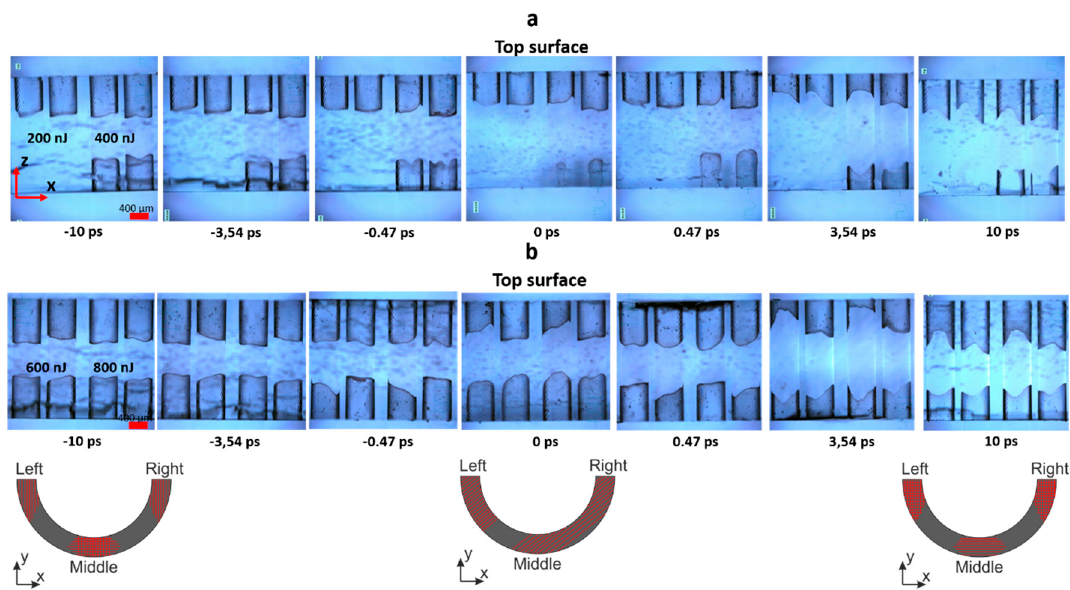
Figure 7. The microscope measurement of the etching dependence on the double-pulse delay for the bow-like vertical structures from the sample side (ZX plane): ( a ) the structures recorded with 200 nJ and 400 nJ pulse energy and ( b ) the structures inscribed with 600 nJ and 800 nJ pulse energy. Two channels with 500 and 1000 ppµ density were recorded at the constant pulse energy. Etching performed for 30 min. in 10% HF. The inset shows the bow-like trajectory view on the XY plane with a predicted nanogratings orientations.